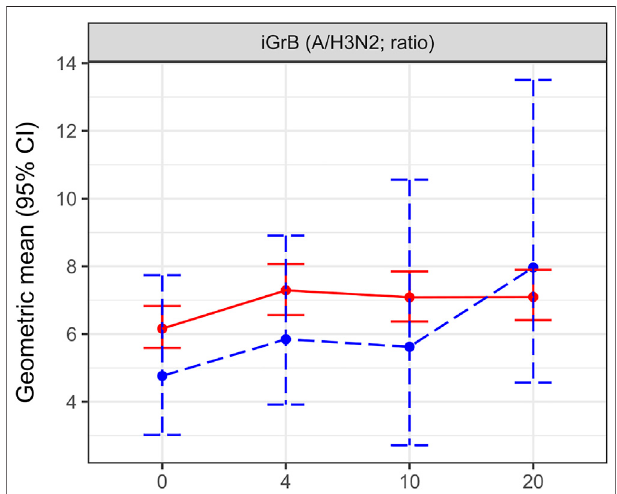
FIGURE 4 | Change over the study period for inducible granzyme B (iGrB) levels in A/Victoria (H3N2) challenged PBMCs strati fi ed by H3N2 laboratory-con fi rmed in fl uenza illness (H3N2-LCII) status at 10 – 2 weeks post-vaccination compared to the Null (No-LCII) subset. iGrB levels at pre-vaccination (0 weeks) and 4, 10 and 20-weeks post- vaccination are presented as the geometric mean and 95% con fi dence interval. Participants without documented LCII are indicated by red, solid lines (n (cid:1) 582); blue, dashed lines indicate participants with H3N2-LCII (n (cid:1) 19).